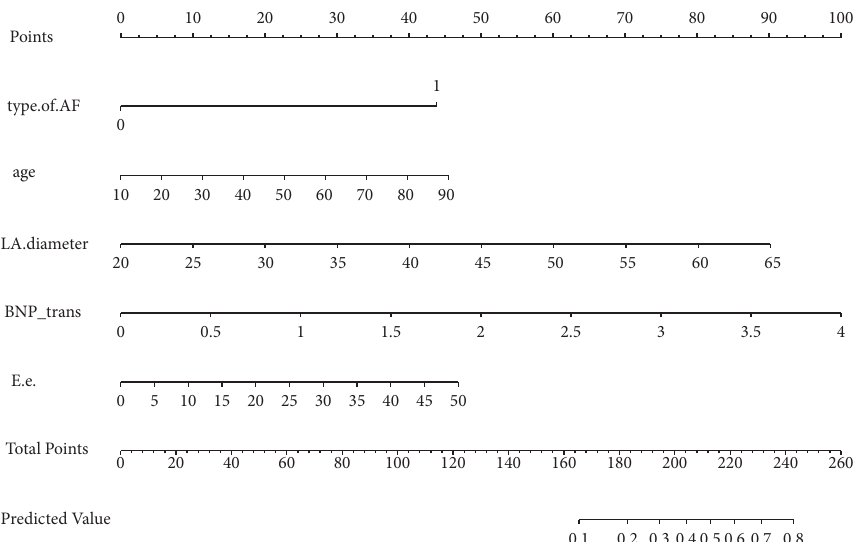
Figure 2: Nomogram for predicting LA/LAA thrombi in patients with NVAF. BNP_trans: Te log10-transformed value of BNP. Te total score is obtained by adding the scores corresponding to the variables in the nomogram. Te risk value corresponding to the total score is the estimated probability of LA/LAA thrombi.